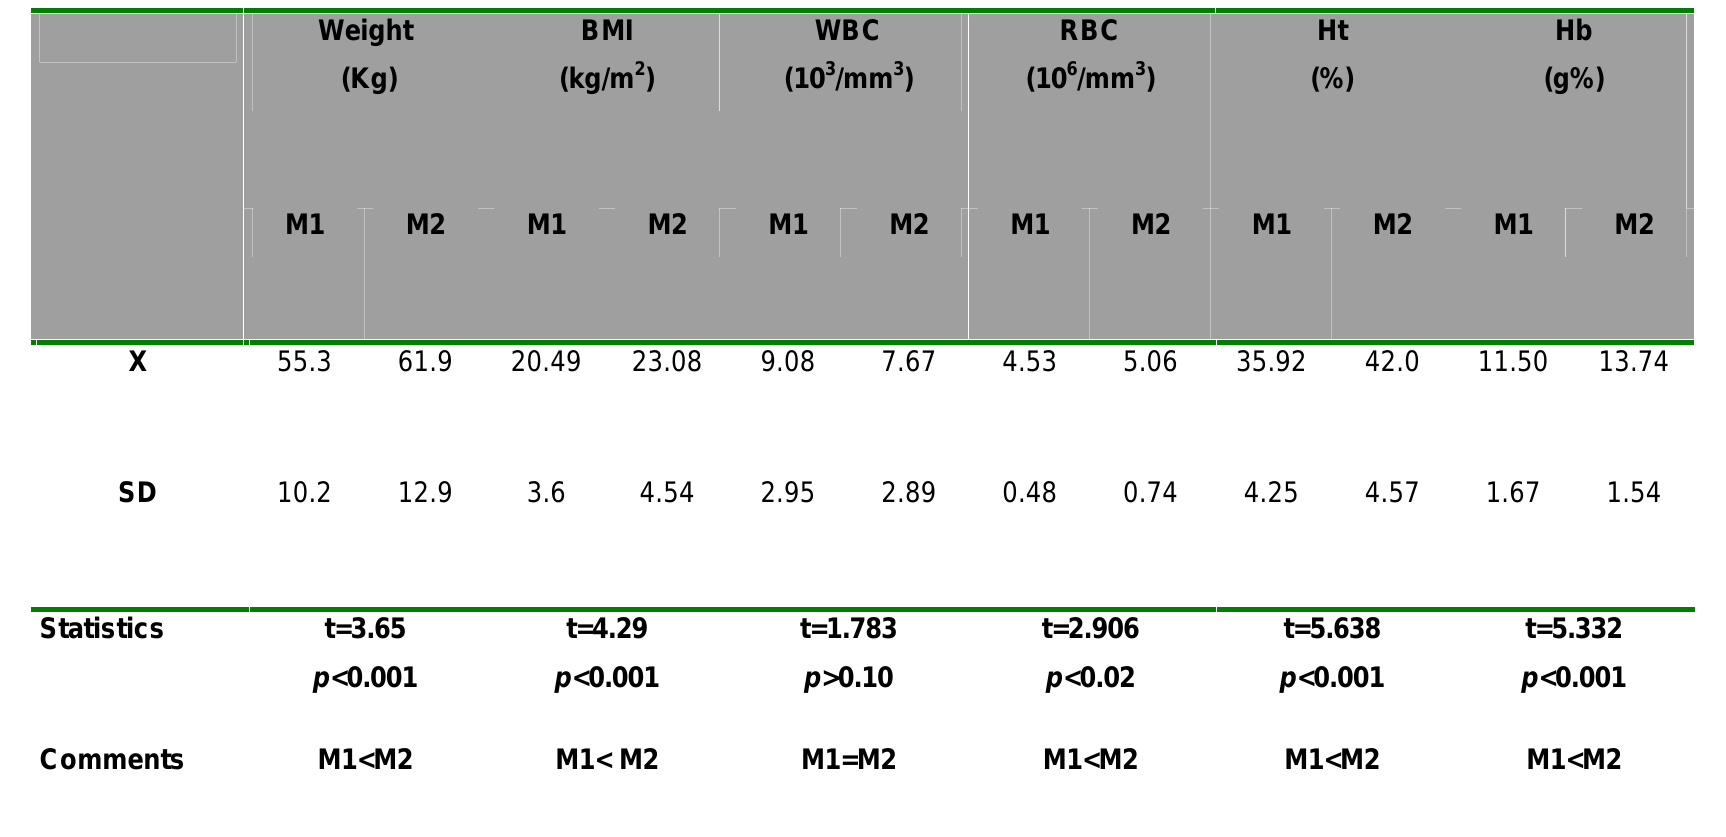
Table 1: Nutritional status and hematometric values (X±SD) of patients with pulmonary tuberculosis at both study moments (M1, before triple treatment; M2, two months after treatment